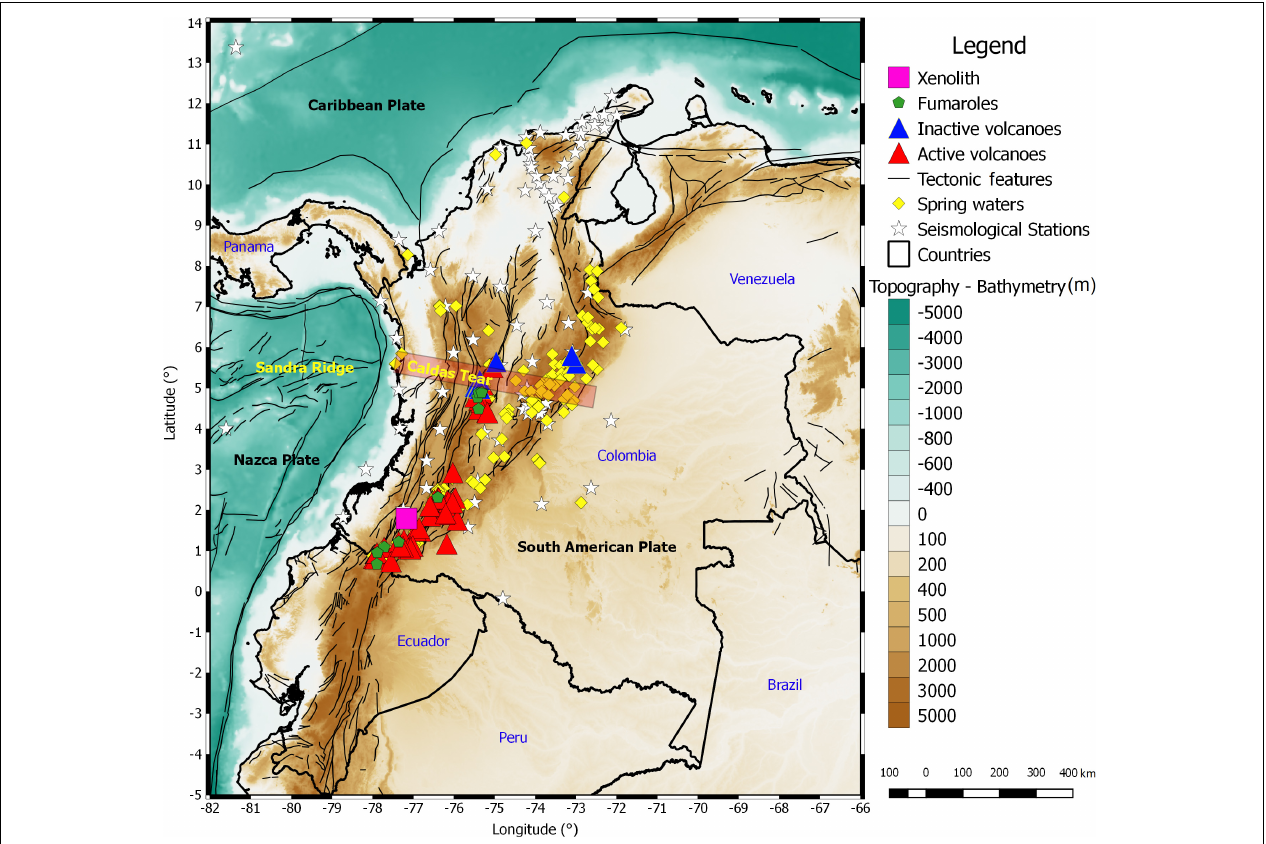
FIGURE 1 | Location of the volcanic arc of the Northern Andes. Triangles represent the active (red) and inactive (blue) volcanoes. Hydrothermal activity is represented by spring waters (yellow diamonds) and fumarolic activity (green pentagons). Tectonic features (black lines) are represented on a bathymetric-topographic map where is highlighted the collinear trend of the Sandra Ridge and the Caldas Tear (pink band). White starts correspond to seismological stations of the Servicio Geológico